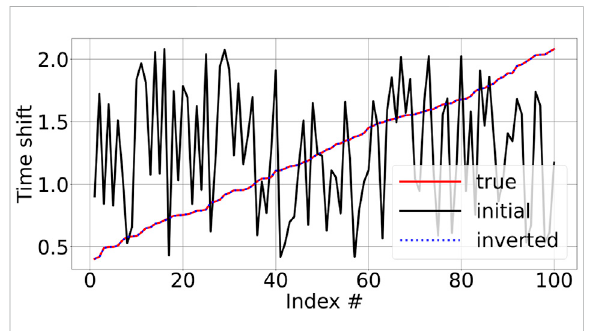
FIGURE 7 Results for 100 true and inverted travel times for the testing dataset for the ML-mis fi t after training.